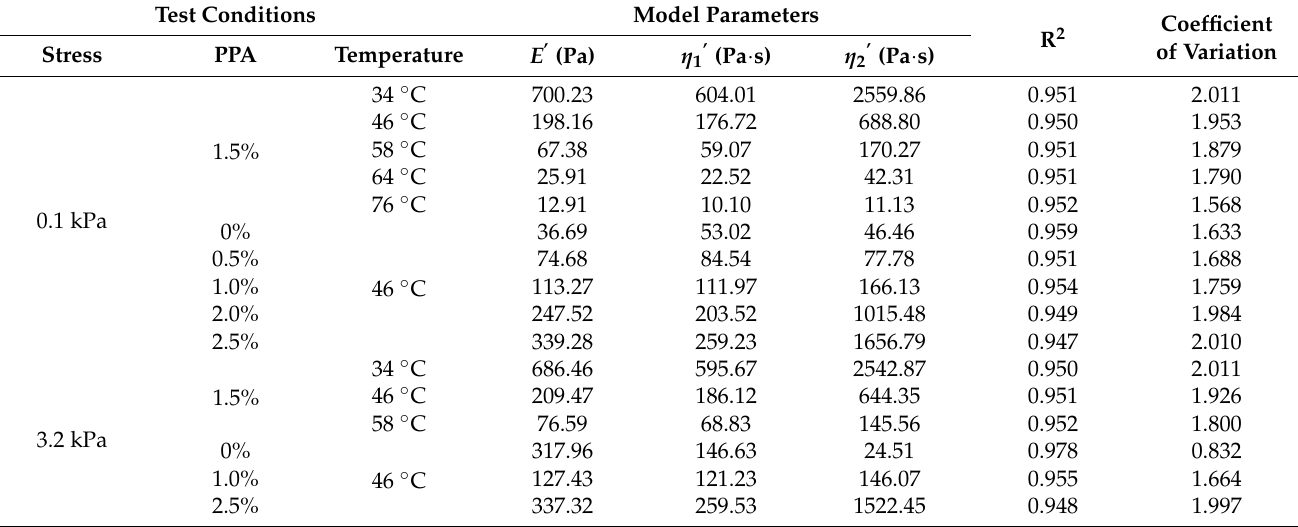
Table 4. Fitting results of Equation (8) to recovery stage.